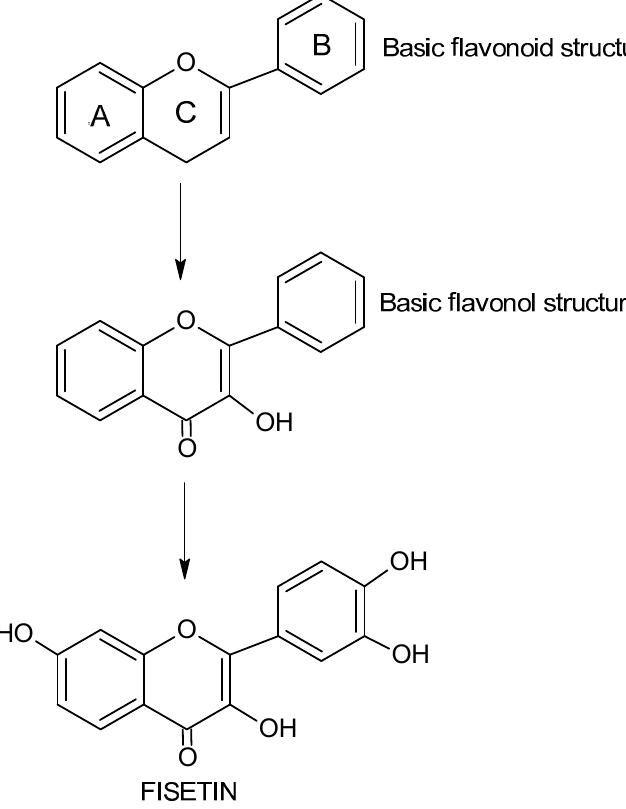
Figure 1. The chemical structure and formula of flavonoids, flavonols and fisetin. Fisetin—General Characteristics